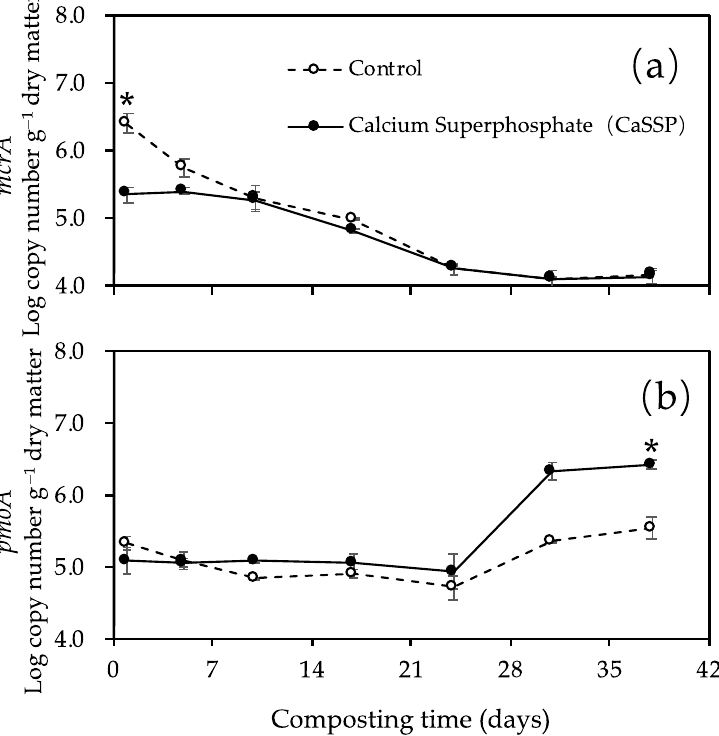
Figure 2. The mcrA (encodes the α -subunit of methyl-coenzyme M reductase) ( a ) and pmoA (encodes the α -subunit of particular membrane bound methane monooxygenase) ( b ) genes copy numbers as affected by CaSSP amendment during windrow manure composting. Control, manure composting; CaSSP, manure composting in combination with CaSSP. Vertical bars indicate standard errors of three replicates. * indicates statistically significant at p < 0.05 by t -test.